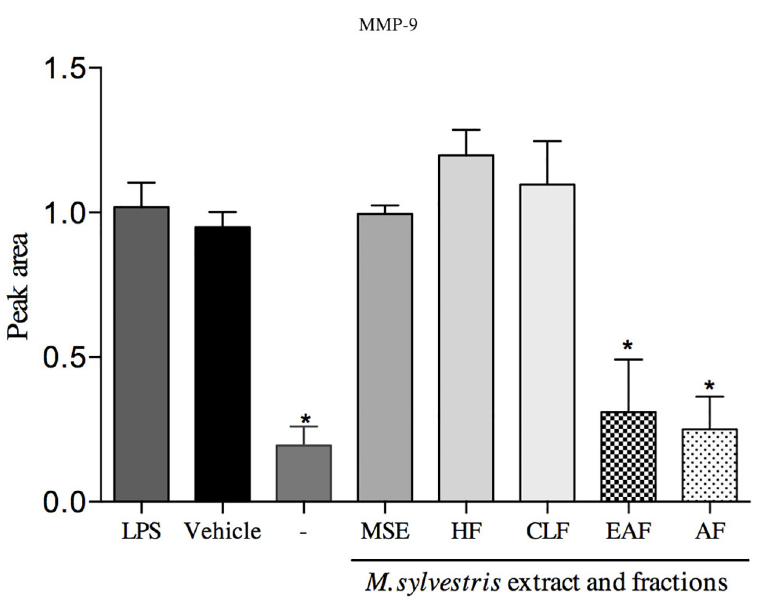
Fig 8. Effect of MSE and fractions on MMP-9 expression levels. Proteolysis activity was stimulated by LPS (E . coli ) 1 μ g/mL. Supernatant was mixed 1:1 with sample buffer and then applied to the gels. Quantification was performed by peak area and normalized by the protein ladder band. Data quantification was performed using ImageJ software. Statistical analyses were performed by one-way ANOVA followed by Dunnett ’ s post-hoc test. * p < 0.05 significantly different from LPS-stimulated